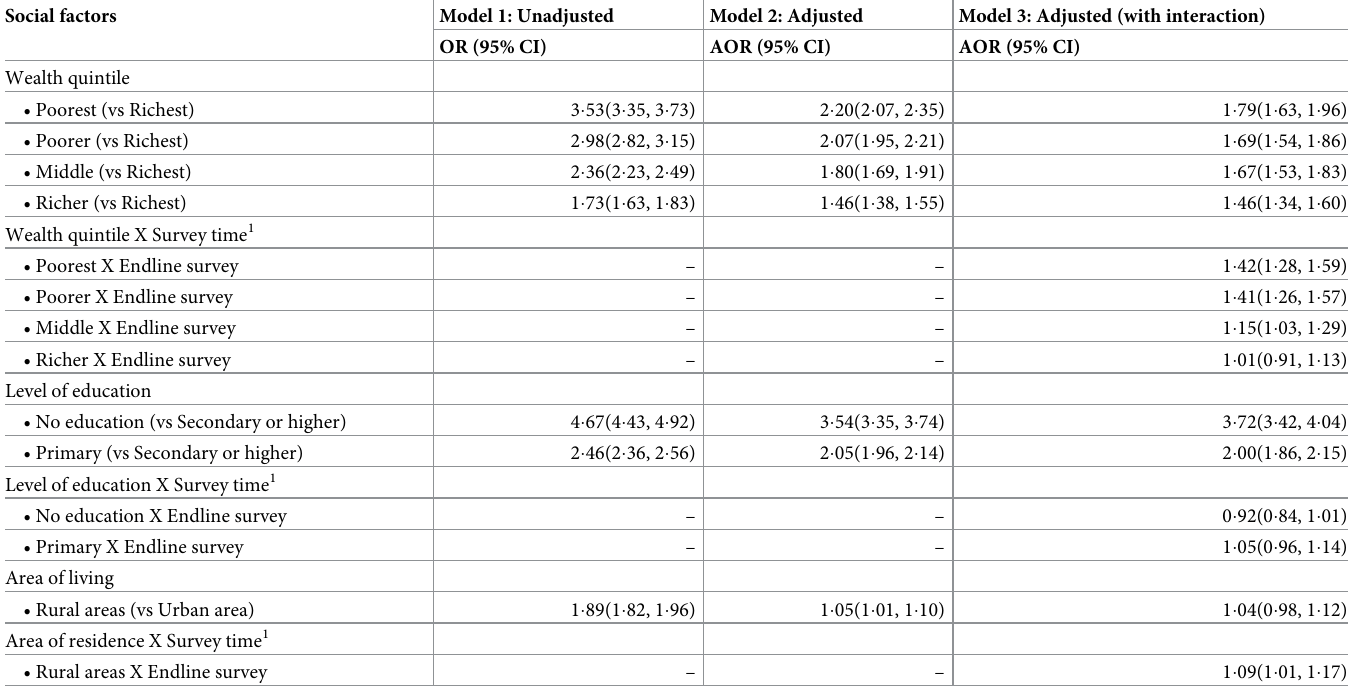
Table 2. Association between social factors and adolescent motherhood in LMICs (AOR): Pooled estimates.